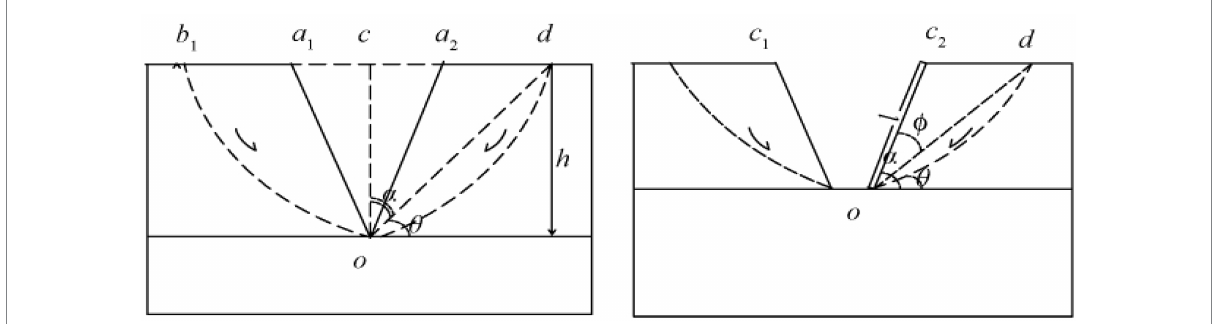
FIGURE 6 Computational model of loose solid